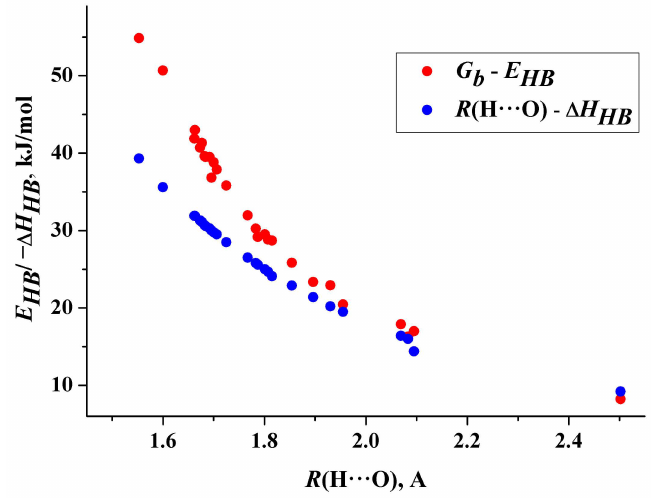
Figure 10. The H-bond enthalpies, − ∆ H HB (Equation (1), blue circles) and the energies, E HB (Equa- tion (2), red circles), evaluated for the considered molecular crystals versus the H ··· O distances computed at the B3LYP/6-31G**